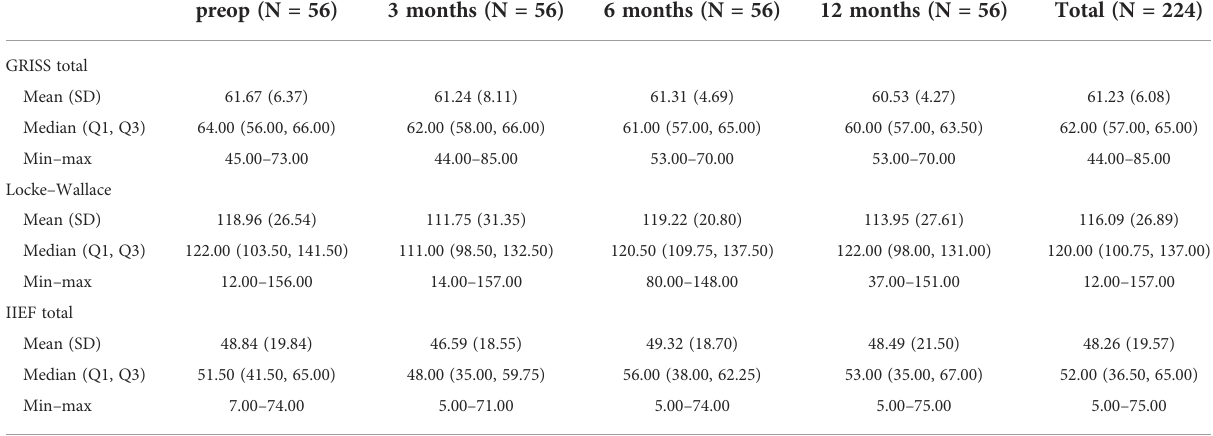
TABLE 4 Summary outcomes for